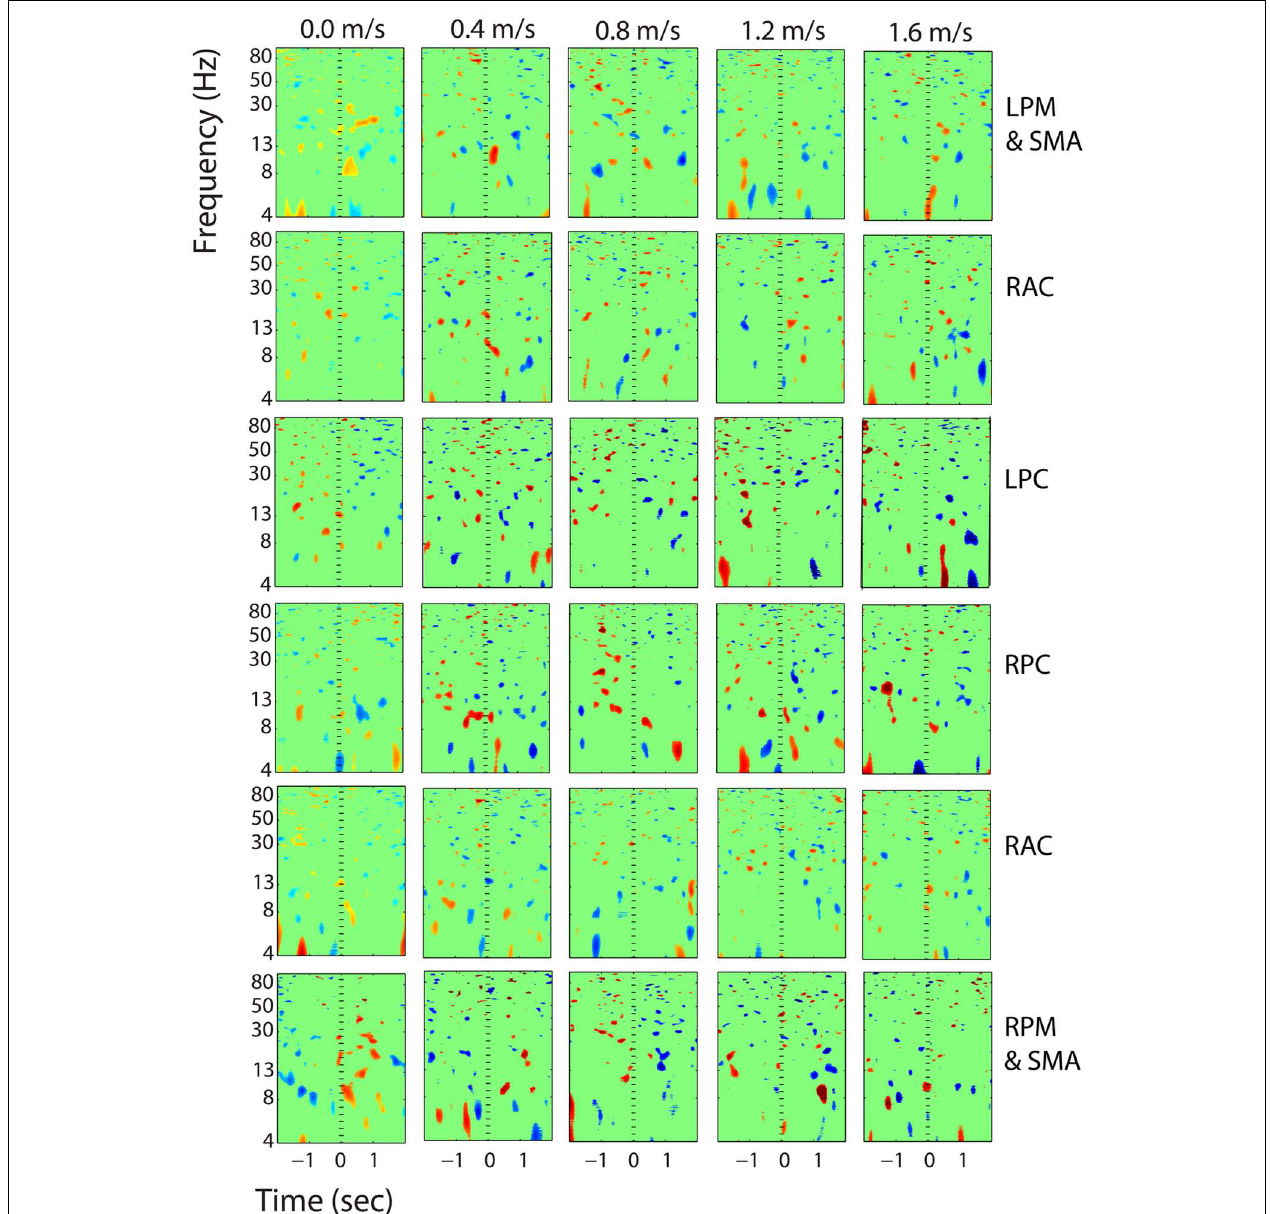
FIGURE 12 | Event-related spectral perturbation plots showing power change around the presentation of a stimulus (a digit and its position in an imagined grid) in the additional six clusters with independent components from > 10 subjects. Each row is one cortical area. From top to